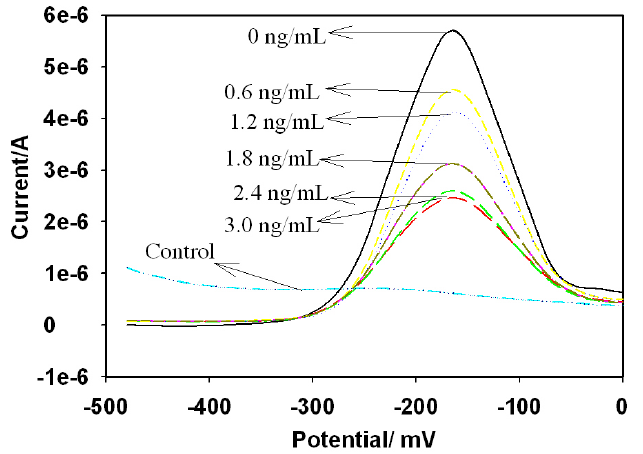
immunosensor (GCE|AuNP|PTH|AFB 1 (mixed with anti-AFB 1 O . DPV experimental conditions: 2 2